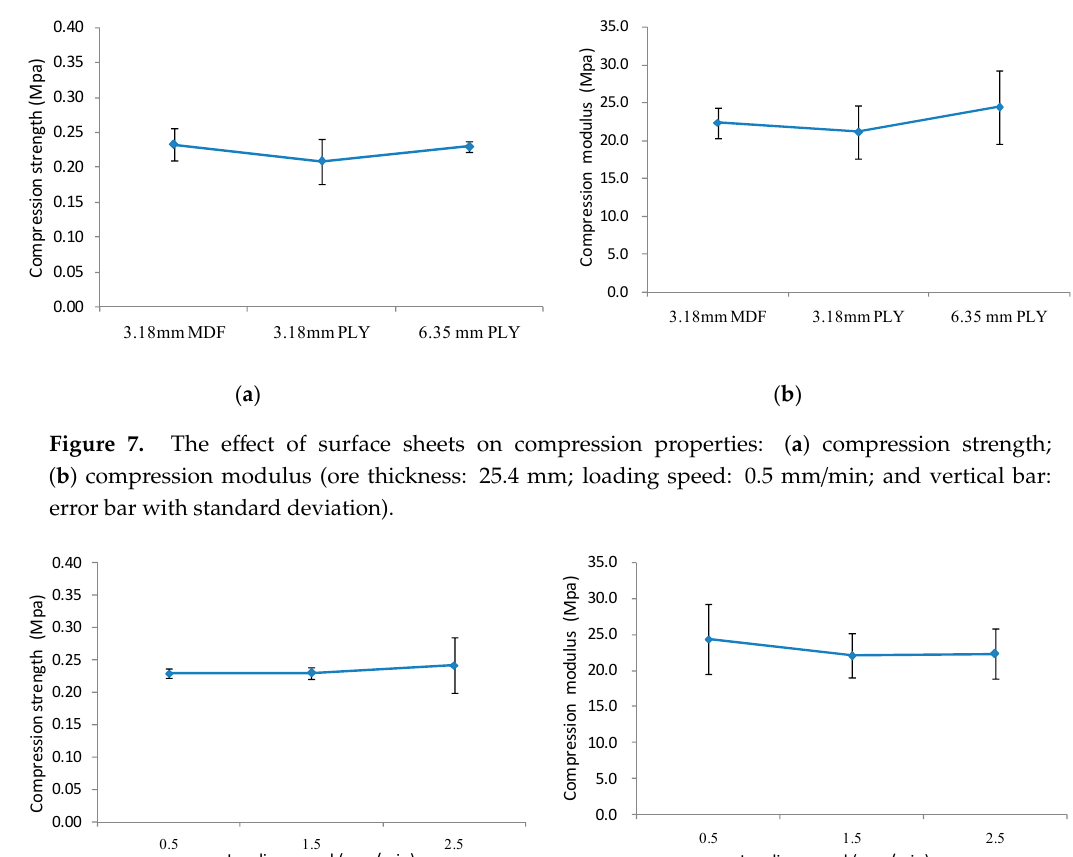
Table 6. Variance analysis summary.